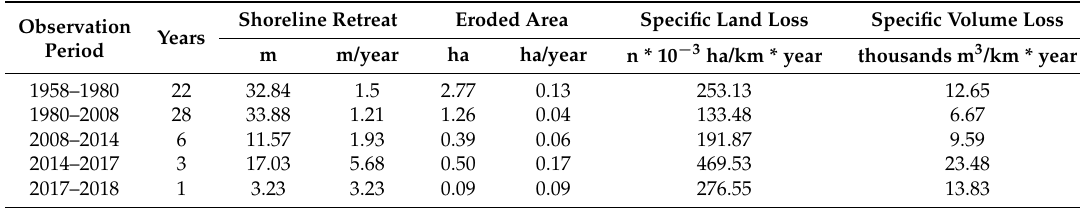
Table 4. Detailed morphometric indicators from different observation periods for Sector 1.